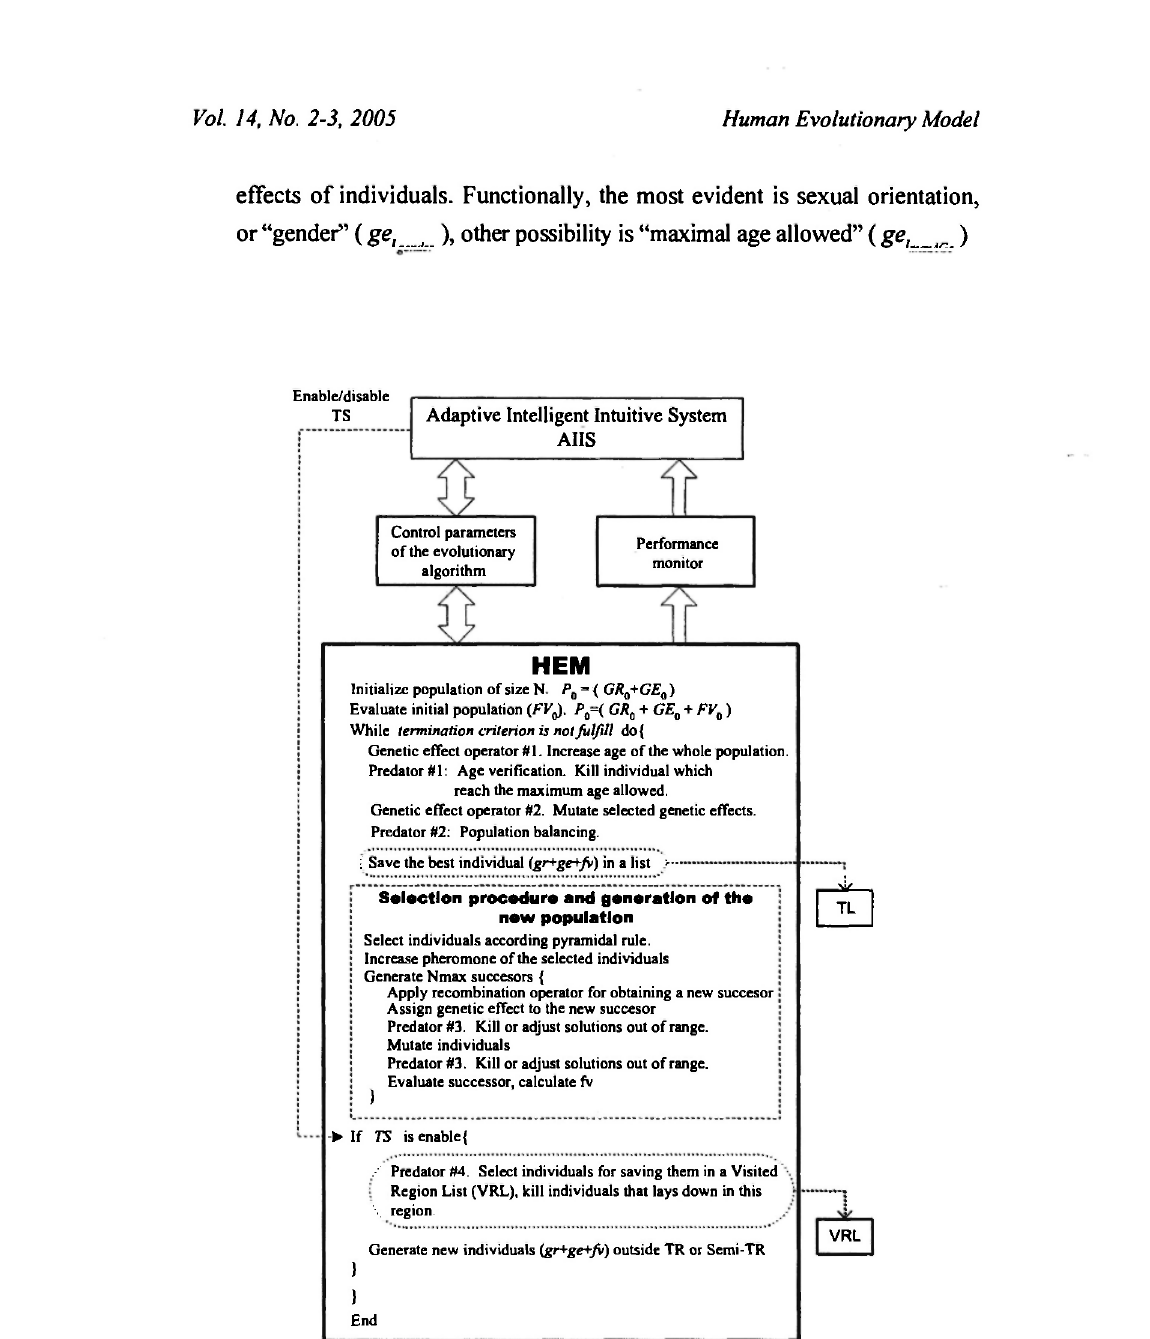
This is a sketch of the Human Evolutionary Model (HEM). We are showing the main components of it, AIIS is controlling all of the parameters of this evolutionary model, cycling can be reduced using trial solutions proposed via TS for continuous